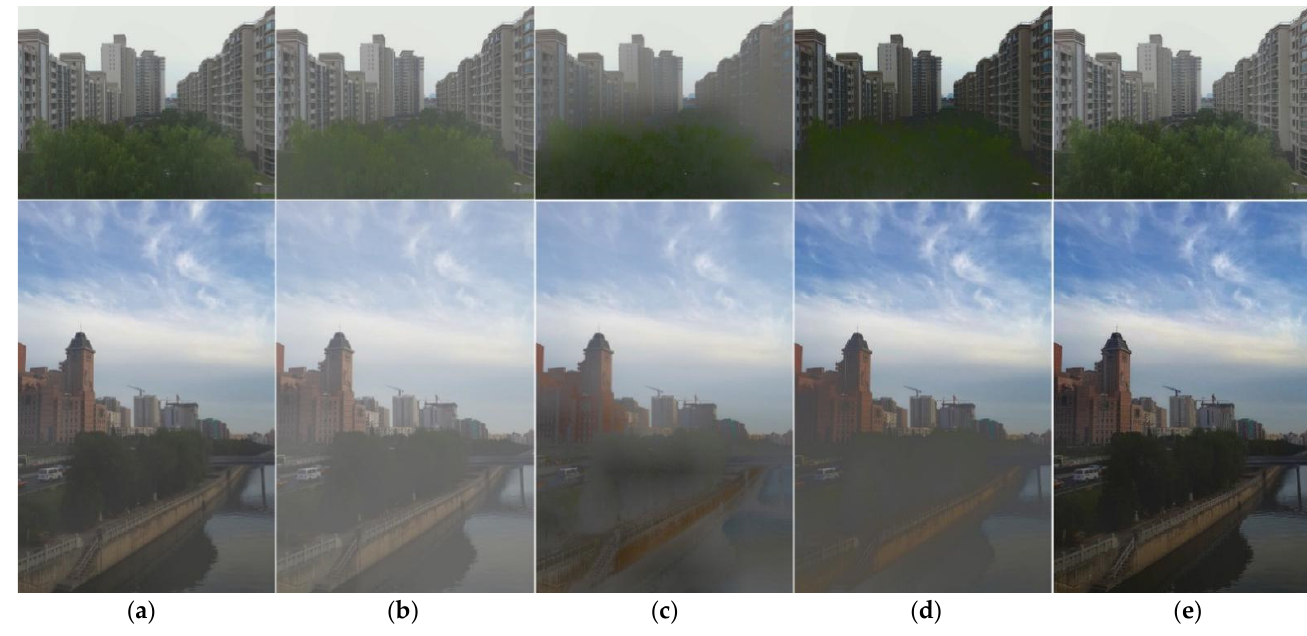
Figure 4. Comparison of outdoor image dehazing for the five methods. ( a ) B1 method processing results, ( b ) B2 method processing results, ( c ) B3 method processing results, ( d ) B4 method processing results, and ( e ) GIC method processing results. Table 1. Comparison of indexes of the five methods.